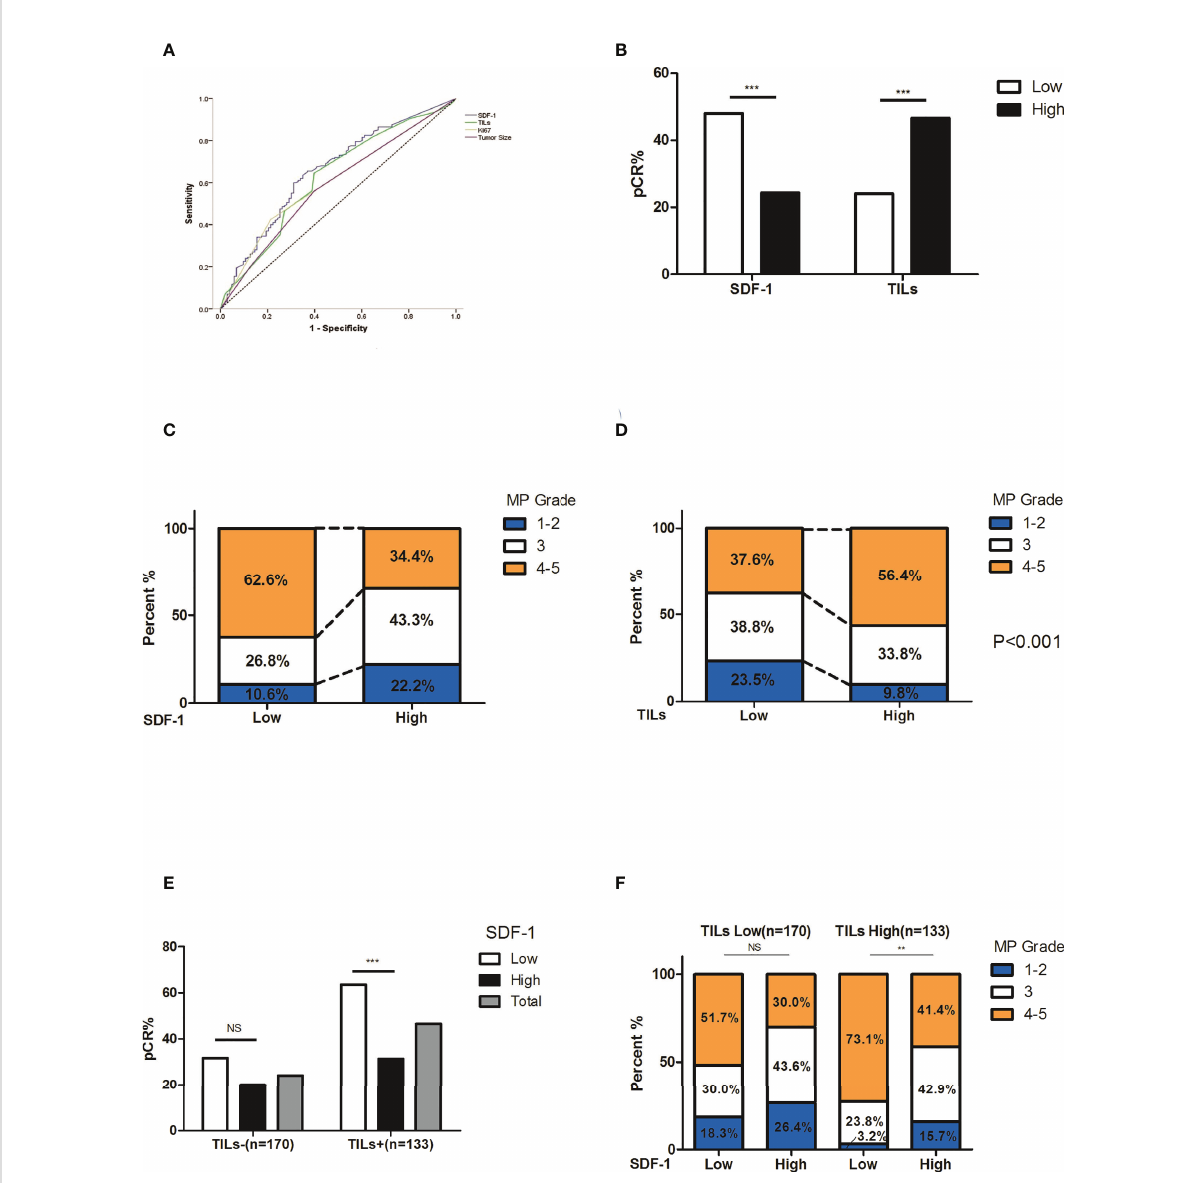
FIGURE 2 Correlation between treatment response and its predictors. (A) ROC curve of pCR predictors. The AUCs were 0.657, 0.624, 0.606, and 0.585 for SDF-1, TILs, Ki67, and T stage, respectively. (B) The rate of pCR and SDF-1 expression. The pCR rate was 48.0% in patients with low SDF-1 expression and 24.4% in patients with high SDF-1 expression (P<0.001). (C) The correlation between the SDF-1 levels and tumor regression (according to MP grades). Notably, there was a higher proportion of favorable responses in SDF-1-low patients. (D) The correlation between TILs and tumor regression (according to MP grades). Notably, there was a higher proportion of favorable responses in SDF-1 high expression patients. (E) The correlation between SDF-1 and pCR according to different TIL levels. The pCR rate in patients with high TILs was 63.5% for low SDF-1 and 31.4% for high SDF-1 (P<0.001). The pCR rate in patients with low TILs was 31.7% for low SDF-1 and 20.0% for high SDF-1 (P=0.089). (F) The correlation between SDF-1 and tumor regression (according to MP grades) according to different TIL levels. Notably, patients with high TILs and low SDF-1 levels experienced a favorable response to NAC. (NS, not signi fi cant; **P<0.01,